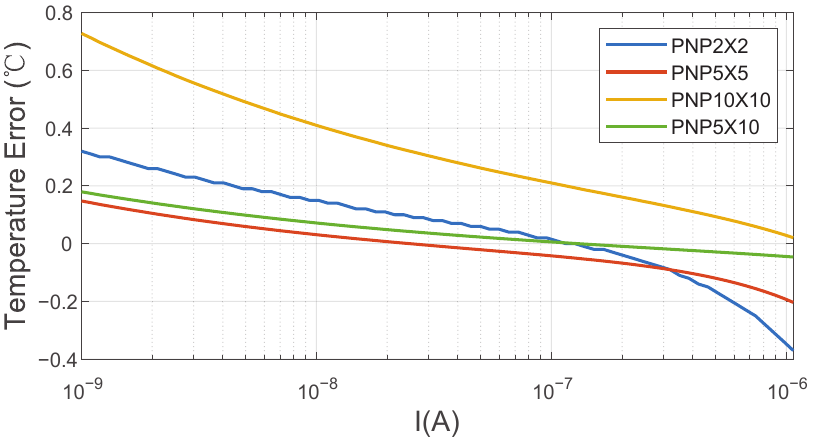
Figure 4. The final temperature error caused by the effect of β on V BE as a function of biasing current I in the 0.18 µ m CMOS